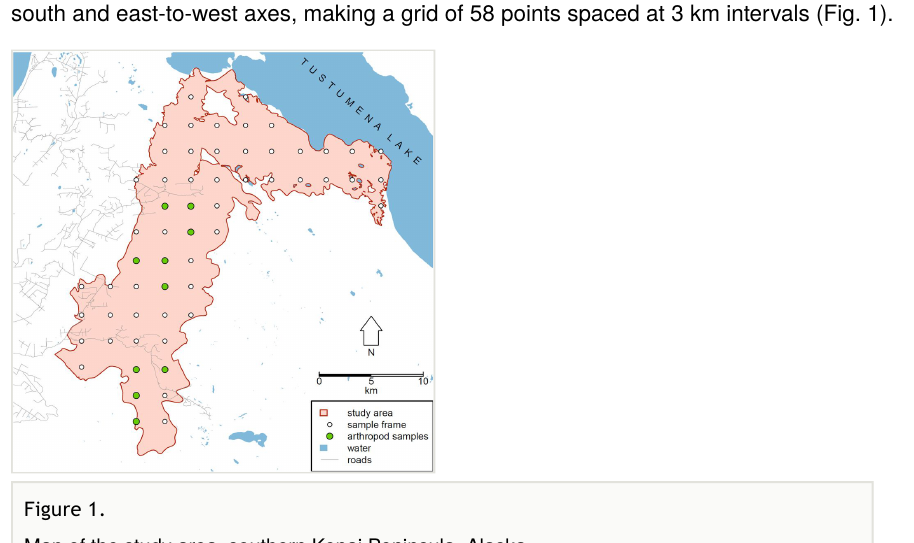
Map of the study area, southern Kenai Peninsula,